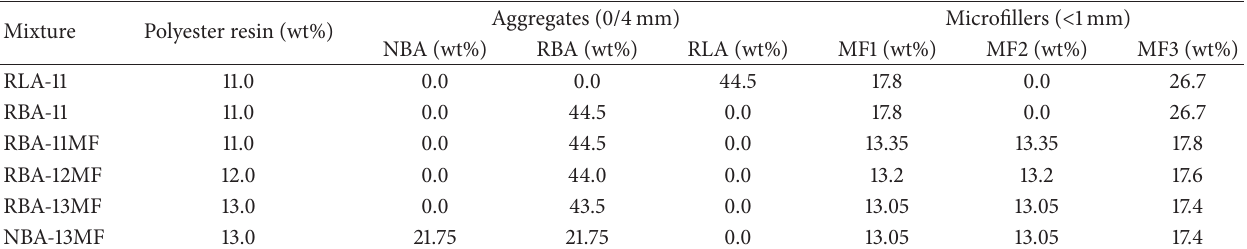
Table 3: Mix proportions of PC containing recycled aggregates from concrete sleepers.